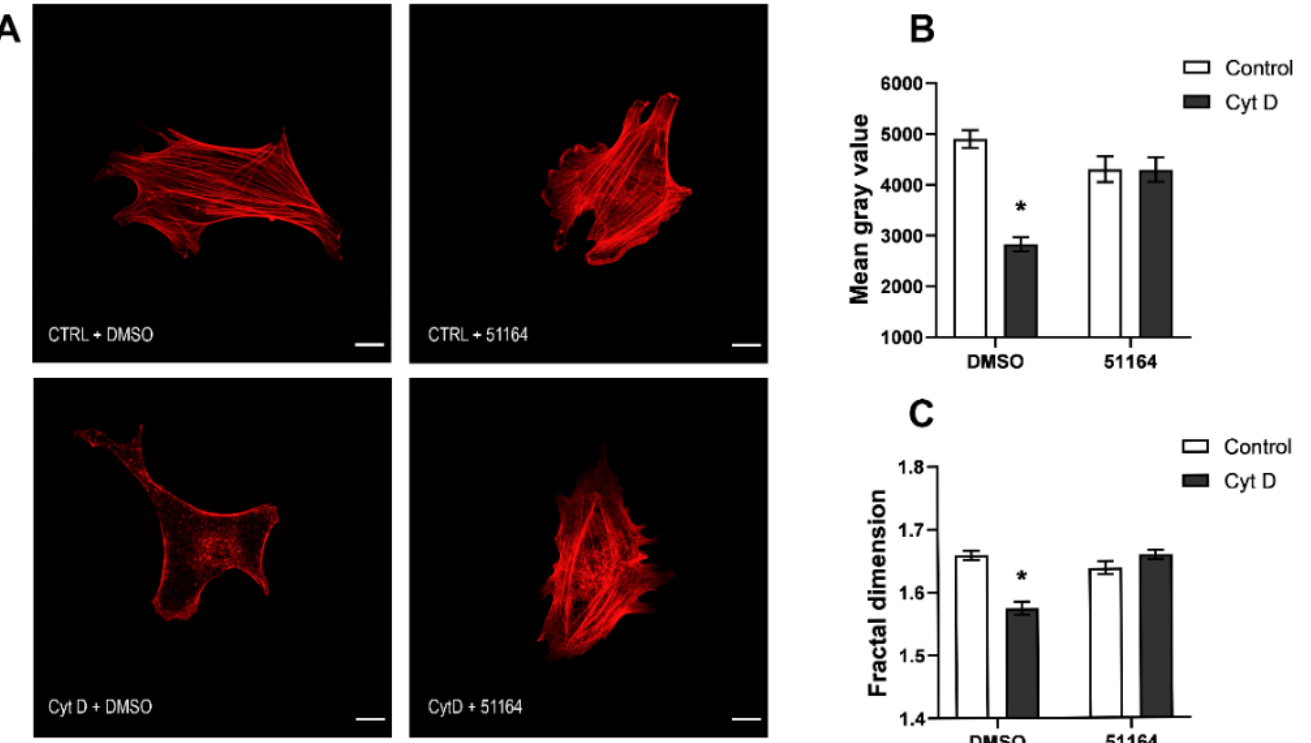
Figure 3. 51164 protects actin filaments in cytochalasin D-treated fibroblasts. ( A ) Representative confocal images of cultured primary mouse fibroblasts stained with rhodamine-phalloidin. The cells were incubated for 15 min in the absence (CTRL) or presence of cytochalasin D (Cyt D) and treated with 1 µ M 51164 or an equal volume of DMSO. Scale bar = 25 µ m. Bar charts of mean gray values ( B ) and fractal dimension mean values ( C ) were calculated for each group of cells. Results are presented as mean ± SEM, n (cells) = 15–35 per group from one experiment, the experiment was repeated three times. Normal distribution was checked by the Shapiro–Wilk test. Two-way